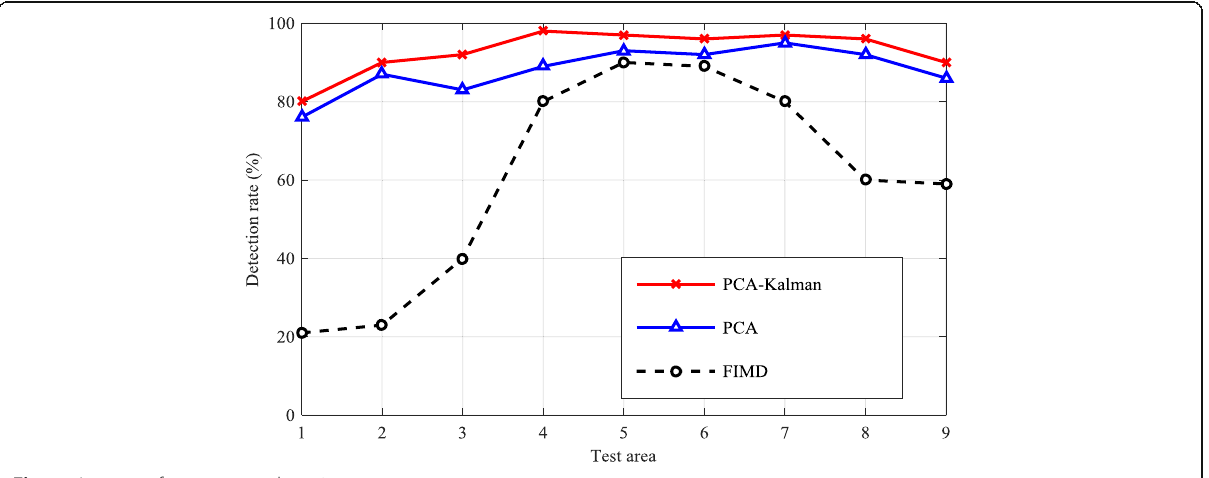
Fig. 11 Impacts of test area on detection